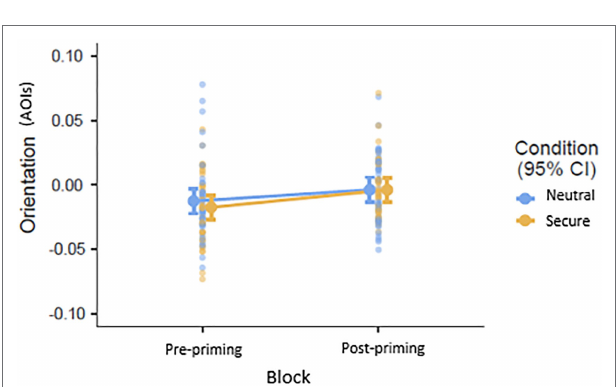
FIGURE 3 | Attention pre- and post-priming: Increased vigilance to all facial stimuli as indicated by reaction times in the dot-probe task where orientation represents Attentional Orientation Indexes (AOIs). Y-axis values represent AOIs where a negative value indicates attentional disengagement, and a positive value indicates attentional engagement. A value of 0 indicates no attentional bias.